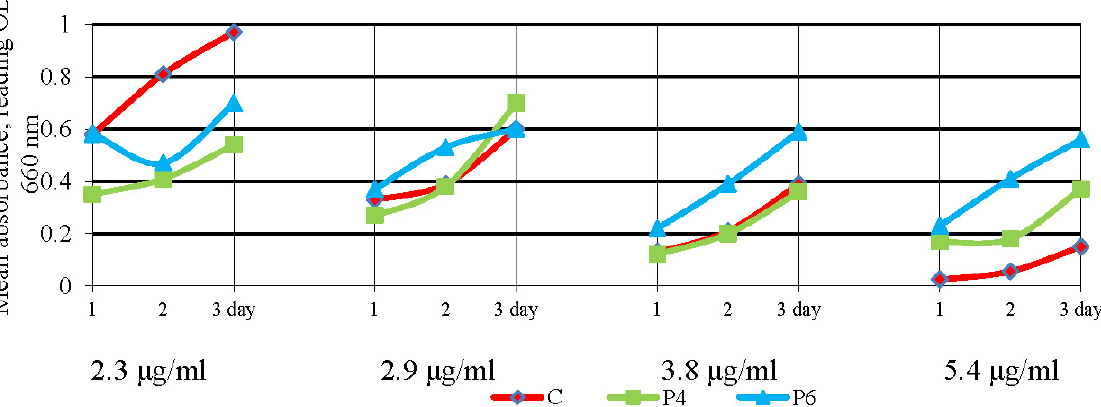
Figure 8. Growth of Staphylococcus aureus ( S. aureus ) under the action of oxytetracycline in complex with polyphosphate ester-type transporters during cultivation in a liquid medium for 3 days. Note. In this and the following figures: C —control (traditional form of antibiotic); P4 and P6 are oxytetracycline in complex with polyphosphate ester-type transporters.